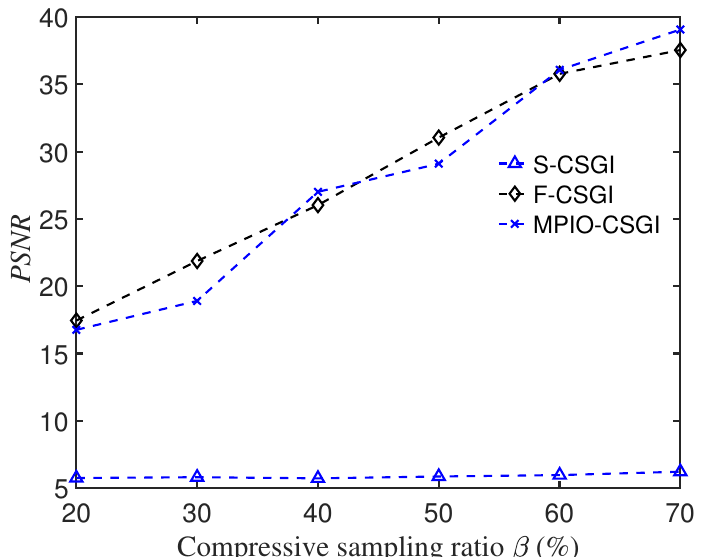
Figure 3. PSNR curves with varying compressive sampling ratios β using F-CSGI, S-CSGI, and